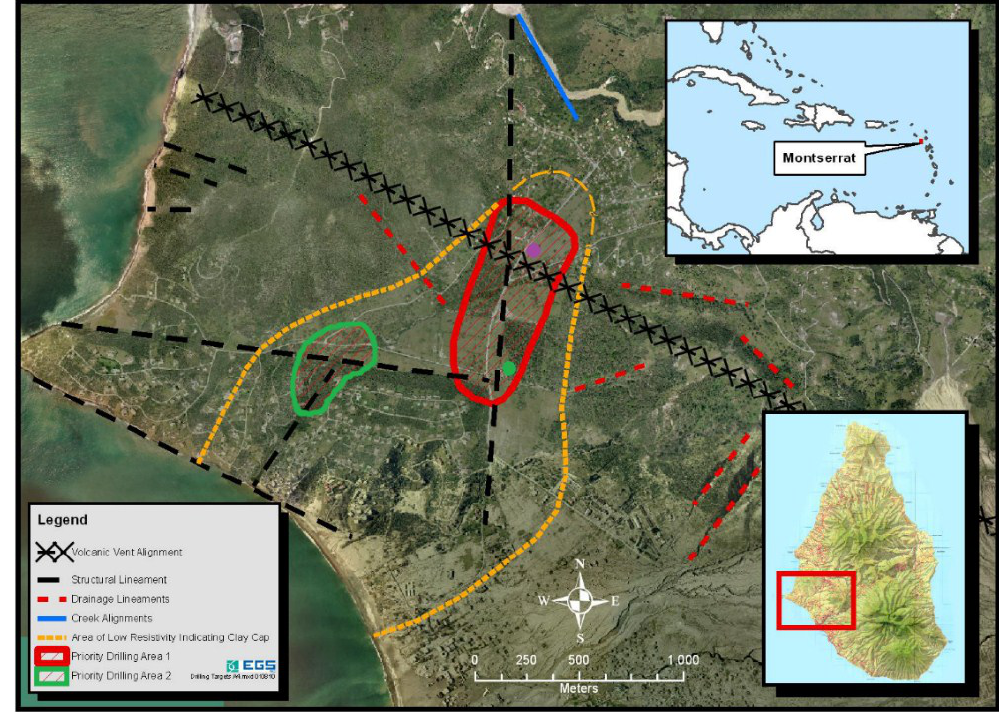
Figure 1. High priority drilling areas (areas outlined in red and green) identified by EGS Inc. [6]. Wells MON-1 and MON-2 are represented as green and purple dots, respectively. Figure modified from EGS Inc.